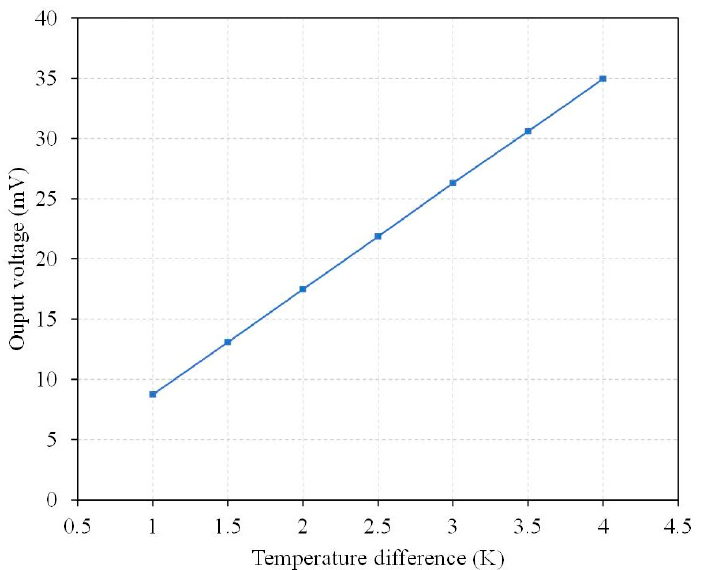
Figure 3. Evaluation of the output voltage for the TEMH.